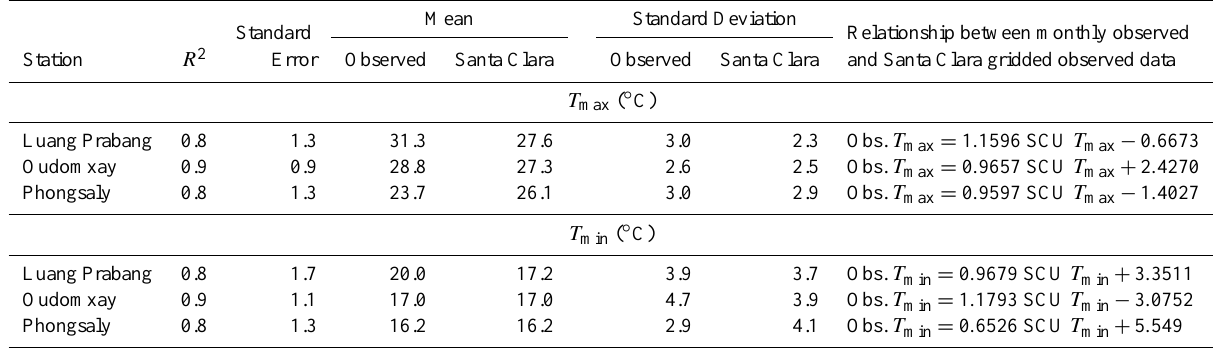
Table 2. Comparison of and relationship between observed and Santa Clara University (SCU) gridded observed monthly temperature data for the 1992–1999 period. Mean Standard Deviation Standard Relationship between monthly observed Station R 2 Error Observed Santa Clara Observed Santa Clara and Santa Clara gridded observed data T max ( ◦ C)